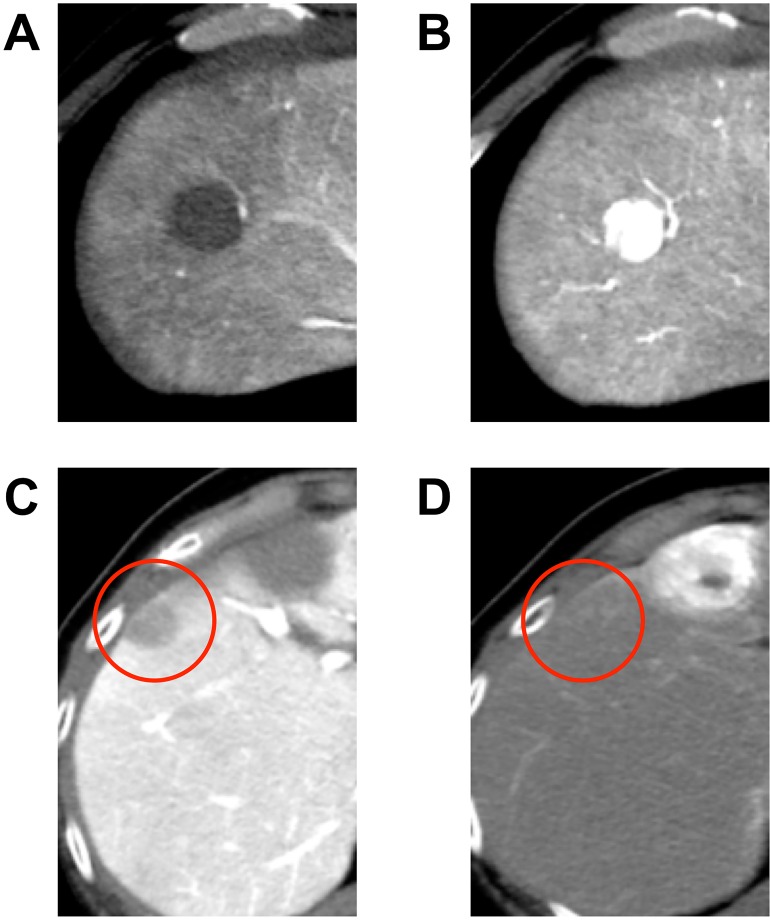
A typical nodule of hypervascular hepatocellular carcinoma (HCC) (A: CTAP, B: CTHA) and a hypovascular nodule (red circle, C: CTAP, D: CTHA). CTAP, computed tomography during arterial portography; CTHA, computed tomography during hepatic arteriography.